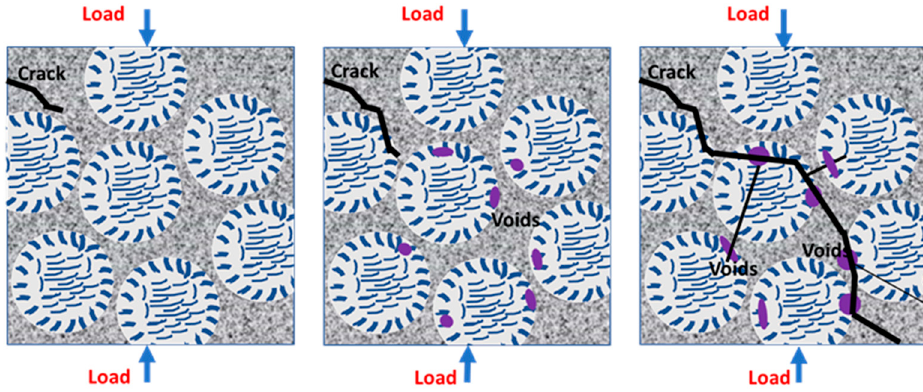
Figure 12. The suggested fracture mechanism of bimodal quaternary Al-Cu-Si-Mg alloy. Table 1. The compressive mechanical properties of current and reported Al-based ultrafine eutectic alloys.